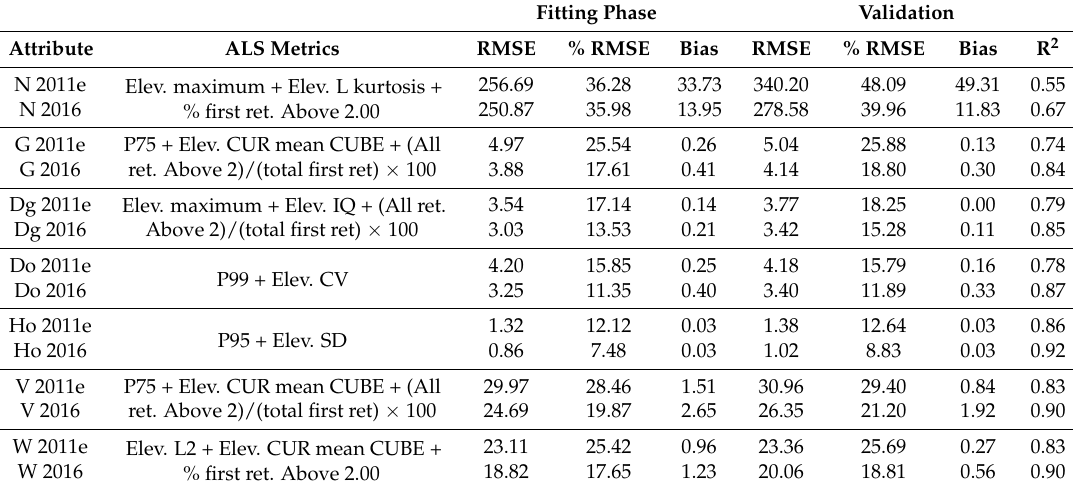
Table 6. Summary of the best-selected SVMr 2016 models and 2011 extrapolated ones. ret. refers to returns; e is extrapolated; N is stand density; G is basal area; Dg is squared mean diameter; Do is dominant diameter; Ho is dominant height; V is timber volume over bark of stem; W is total tree